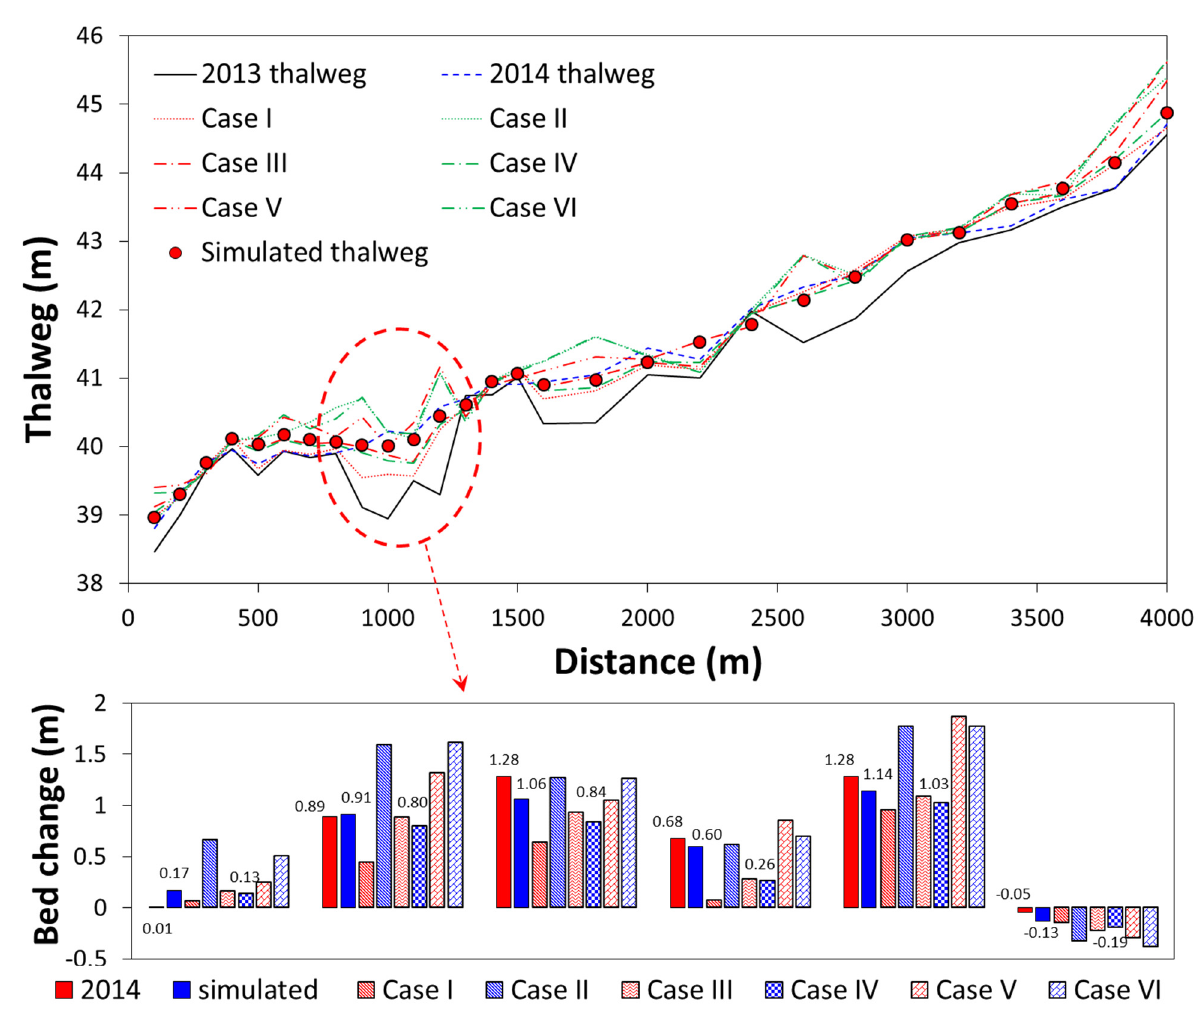
Figure 9. Simulated and surveyed results of river bed change along thalweg with six cases of simulation discharge scenarios. Table 5. Errors of river bed change between the simulated and the surveyed at the 28 cross sections. Errors of Bed Change between the Surveyed Classification